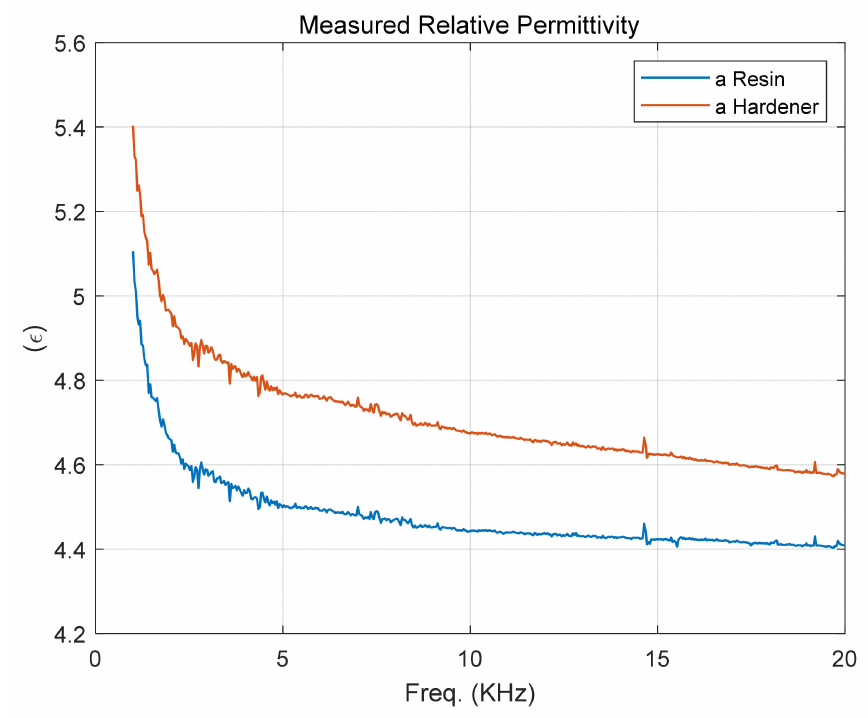
Figure 13. Measured relative permittivity of a resin and a hardener at 20.2 ◦